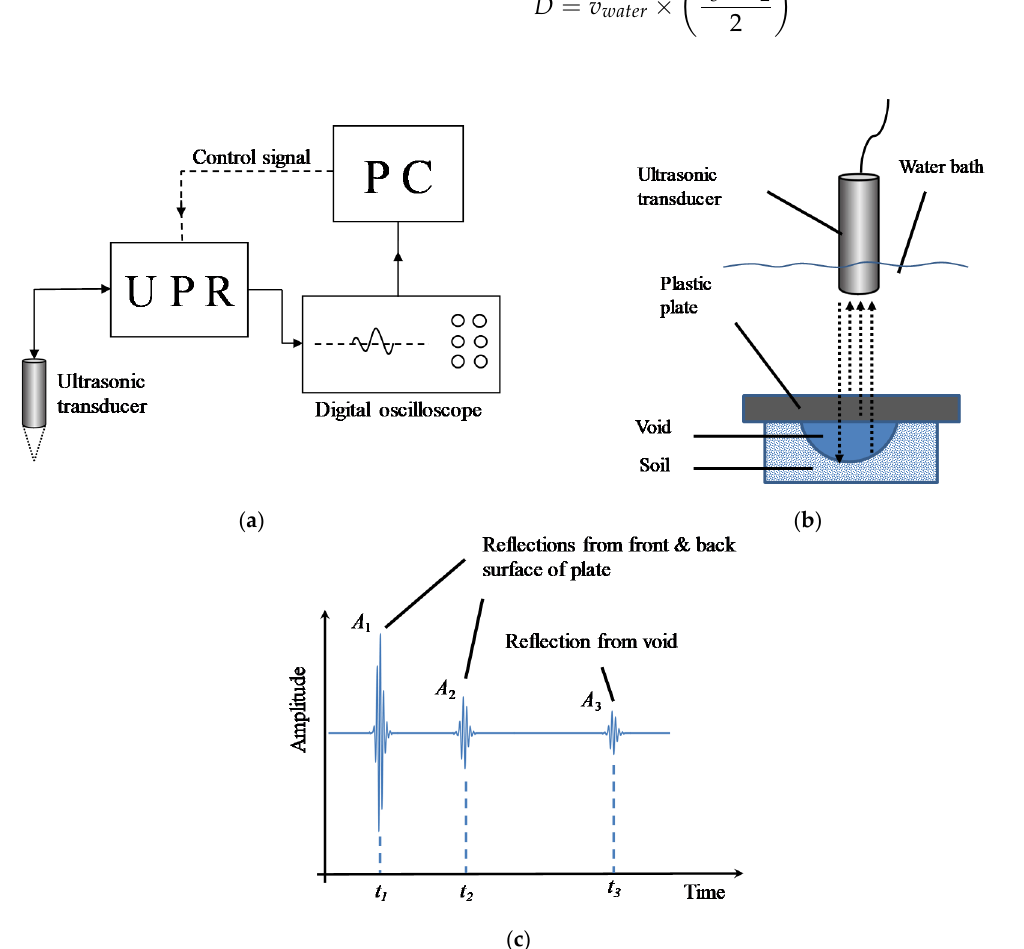
Figure 1. ( a ): Sketch of ultrasonic unit used in this study; ( b ): roundtrip-propagation and reflections of ultrasound waves from front/back surfaces of the plate and the soil surface; ( c ): An A-scan example of ultrasonic measurement containing three reflections from three surfaces in ( b